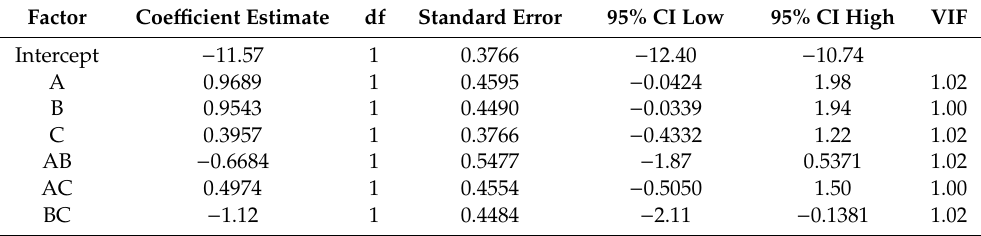
Table 8. Coe ffi cient estimates demonstrating the response change per unit change in factor value when the remaining factors remain constant. The intercept is the average response of the runs. The coe ffi cients are normalized by the average. For orthogonal factors the VIFs are 1; VIFs > 1 are the indications of